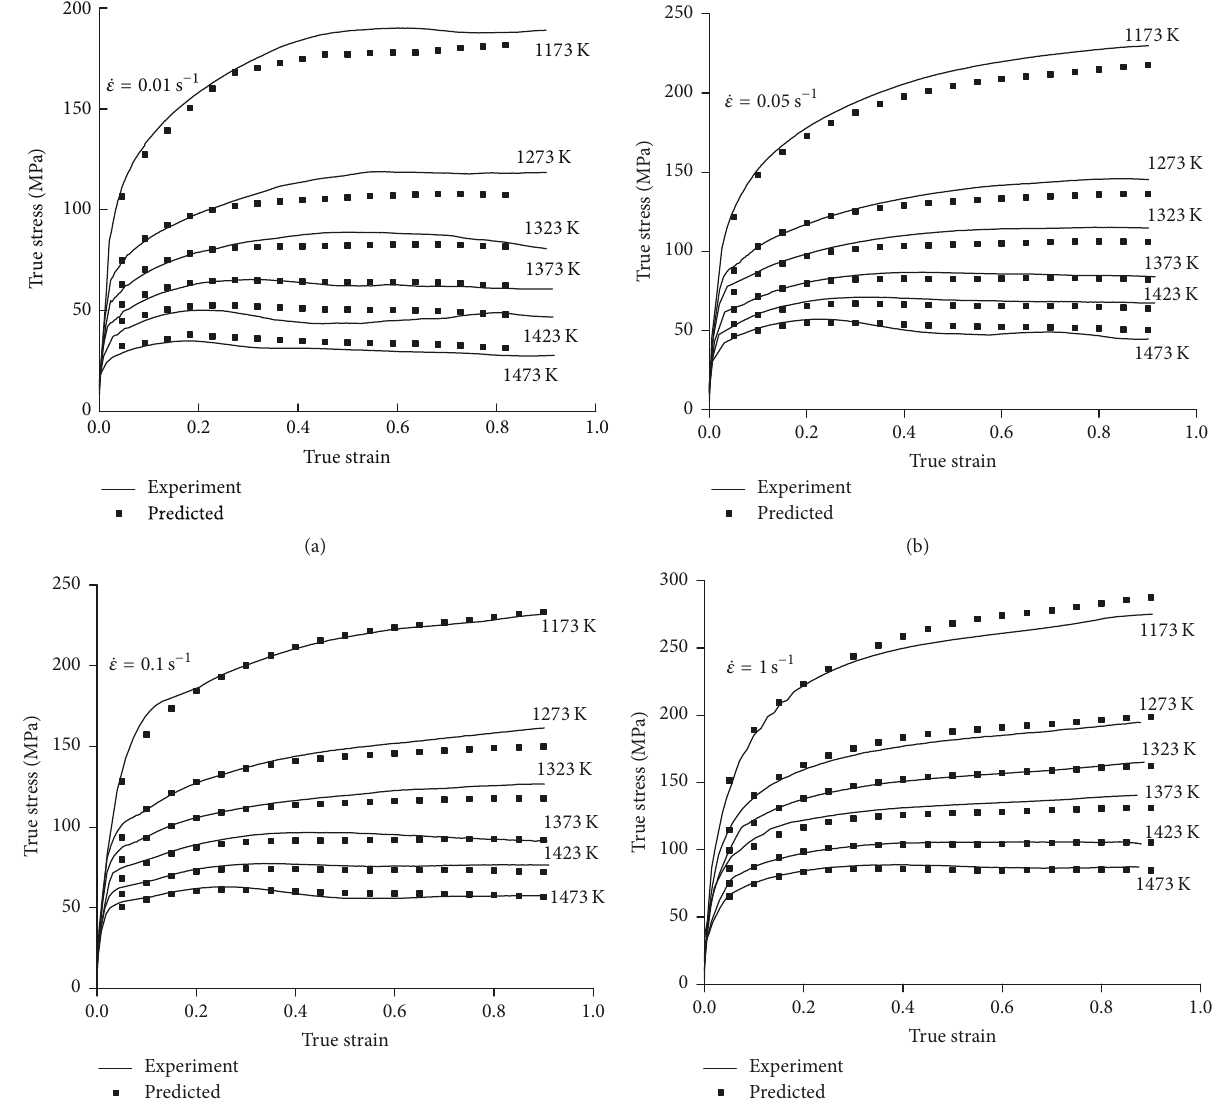
Figure 13: Comparisons between predicted and experiment flow stress by the proposed constitutive model under different deformation temperatures at strain rate of 0.01 s −1 (a); 0.05 s −1 (b); 0.1s −1 (c); 1s −1